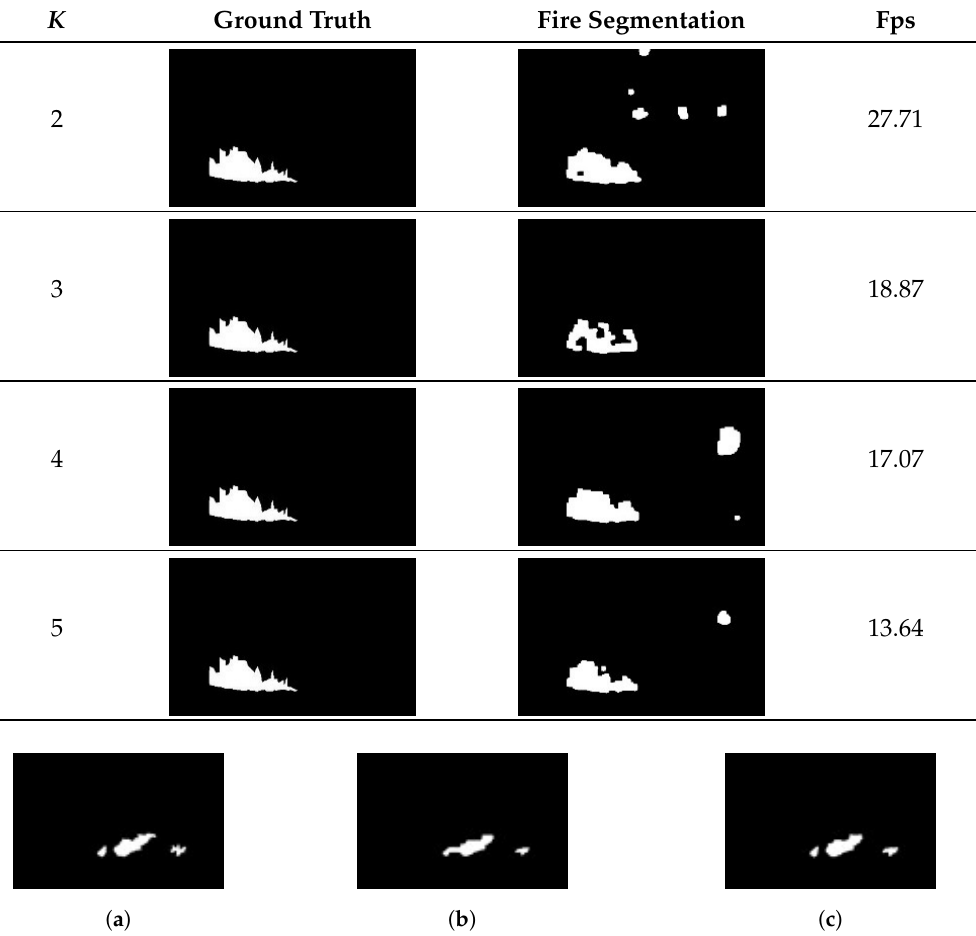
Figure 5. The effect of morphological operations on the segmentation result. ( a ) Ground truth; ( b ) without dilation operation; ( c ) with dilation